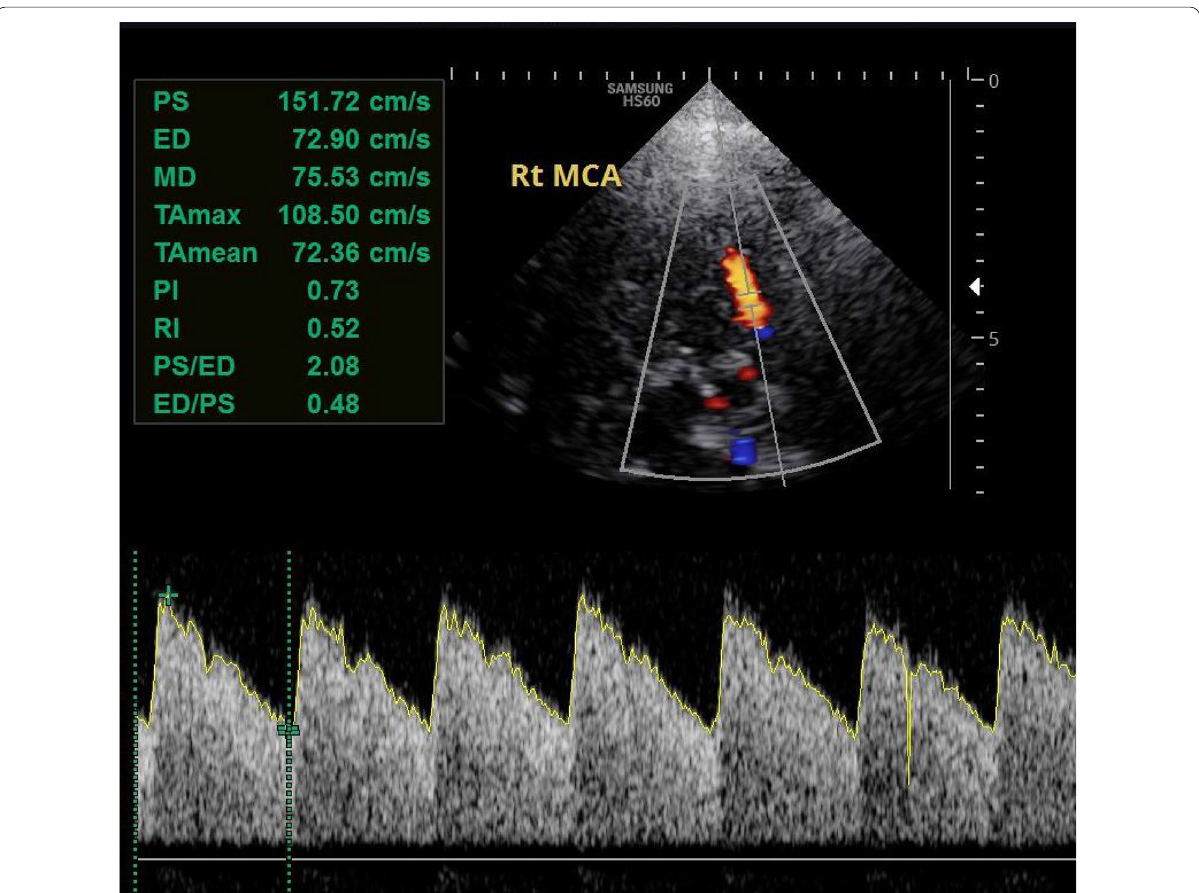
Fig. 6 Transcranial Doppler for a 10 years old male on occasional blood transfusion showing the TAMAX within the right MCA to be 108 cm/s (i.e., less than 170 cm/s),indicating no risk of stroke